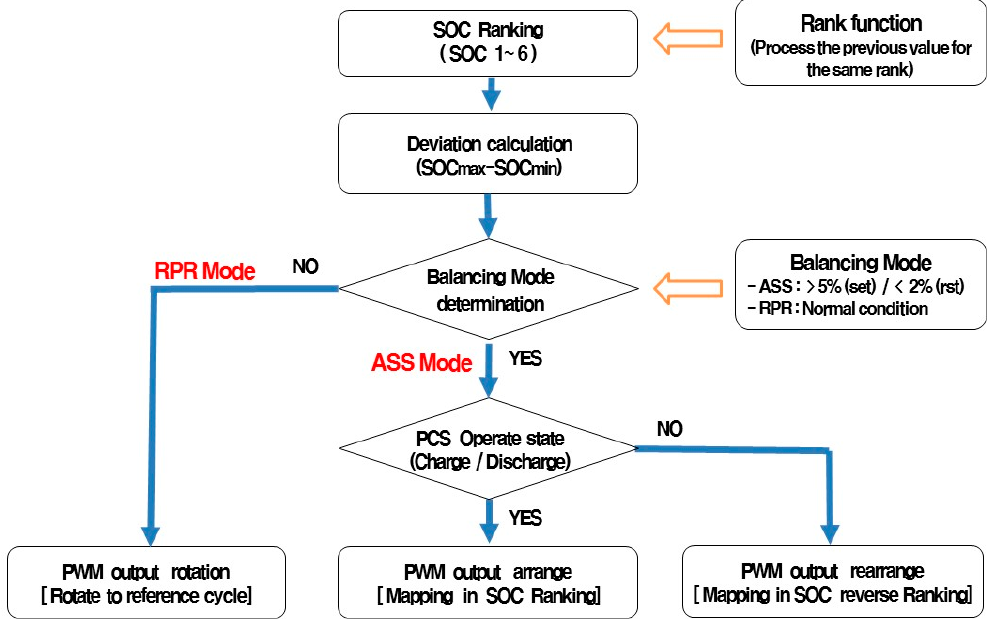
Figure 13. Battery balancing algorithm sequence diagram.